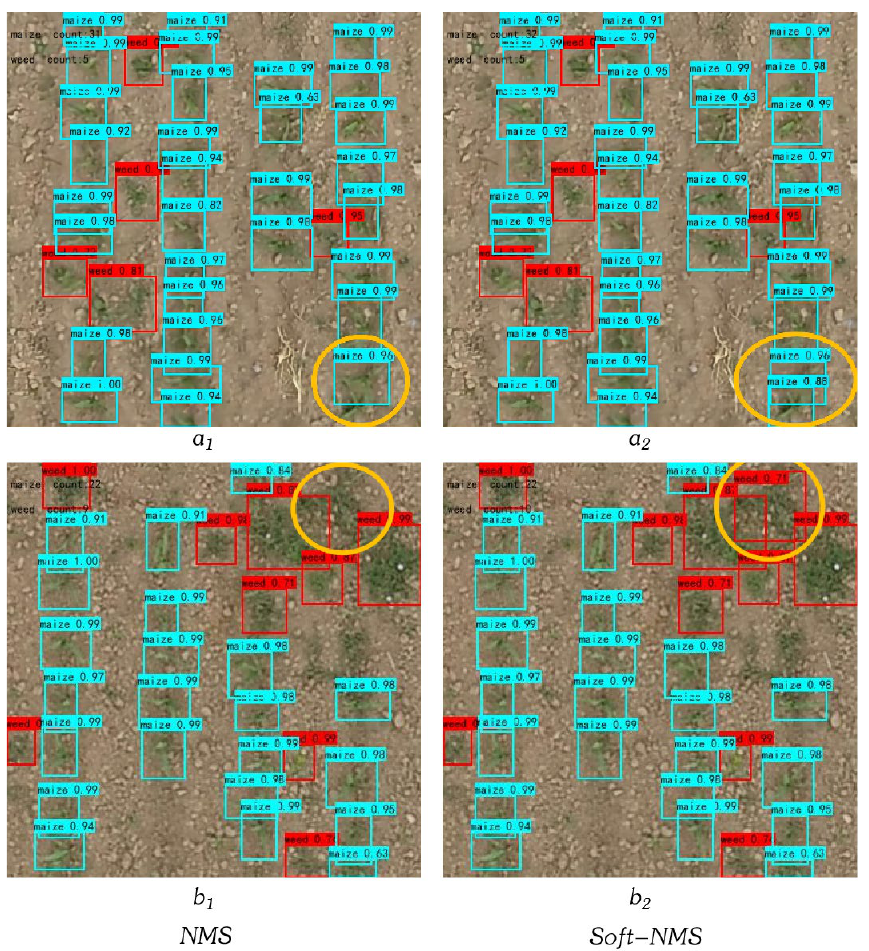
Figure 8. Comparison of the detection results between NMS and Soft-NMS. ( a 1 ) NMS cannot detect overlapping maize; ( a 2 ) Soft-NMS can detect overlapping maize; ( b 1 ) NMS cannot detect overlap- ping weed; and ( b 2 ) Soft-NMS can detect overlapping weed.